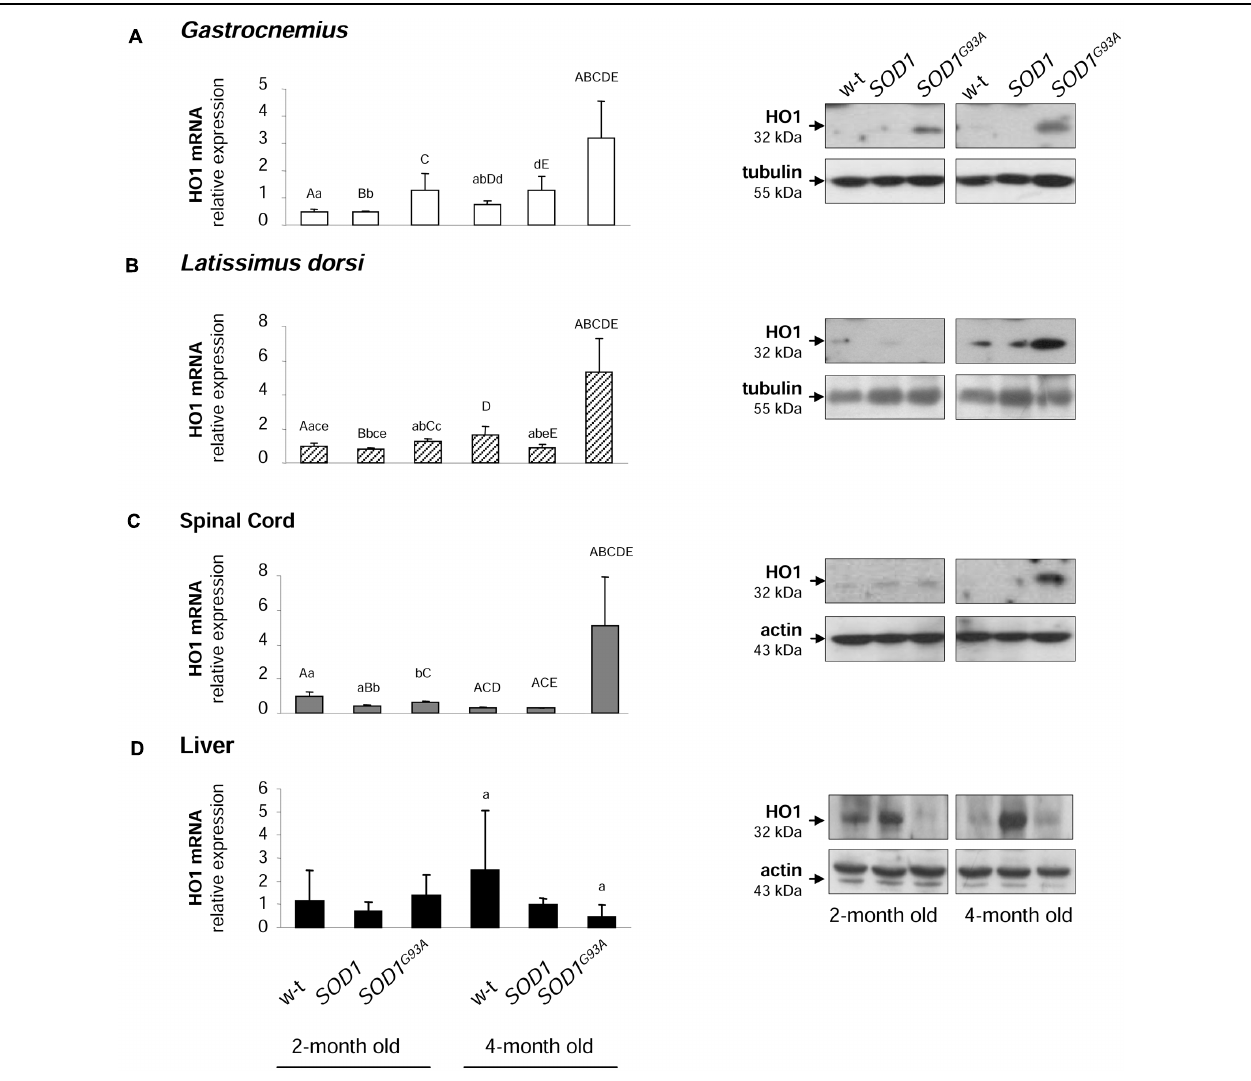
FIGURE 8 | Analysis of HO1 mRNA abundance and protein levels in tissues of experimental mice. HO1 transcript abundance was measured in skeletal muscle (A,B) , neuronal tissues (C) , and liver (D) (left-hand) by real-time RT-PCR as described in M&M. The histograms display HO1 mRNA levels after normalization to 18S ribosomal RNA levels. Each column represents the mean ± SD of three biological amplification reactions. RNA from each mouse was extracted separately using TRIZOL reagent, reverse-transcribed and amplified as described in M&M; therefore, 18 cDNA samples (biological triplicates for each condition) were finally used in the analysis of gene expression in each tissue. The same capital and small letter indicates groups between which statistically significant differences were found at P < 0.01 and P < 0.05, respectively. Western blot analysis of HO1 protein levels was performed in membrane extracts obtained from the above-mentioned tissues (right-hand). Data are representative for three independent Western blot analyses performed using extracts from three mice of each experimental group. The intensity of the HO1 bands (relative to the intensity of tubulin or actin bands) was quantified with a molecular Imager using Quantity One software (Bio-Rad) and is shown in arbitrary units to present protein level. Results are expressed as mean ± SD for three mice in each experimental